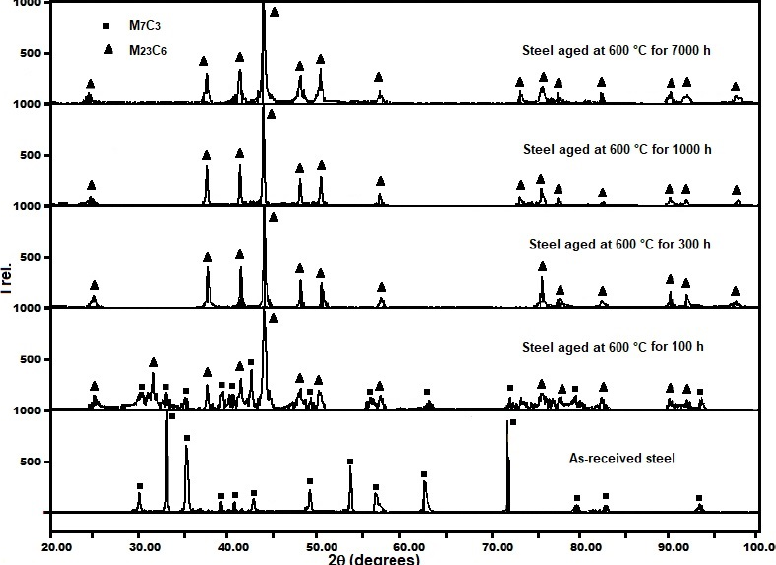
Figure 5. SEM micrograph of extracted residues of the steel after aging at 600 °C for ( a ) 0, ( b ) 300 and ( c ) 7000 h.